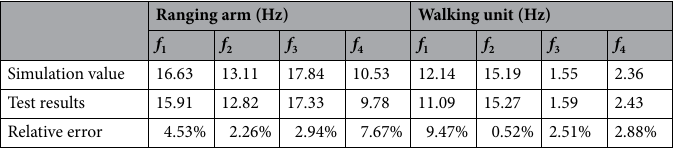
Table 7. Comparison between simulated and experimental values of vibration